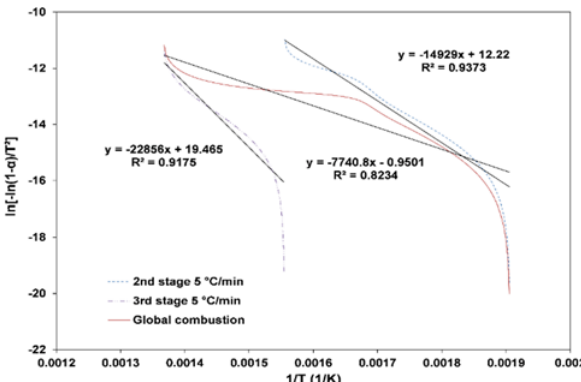
Figure 9. Illustration of the method used to determine the kinetic parameters.